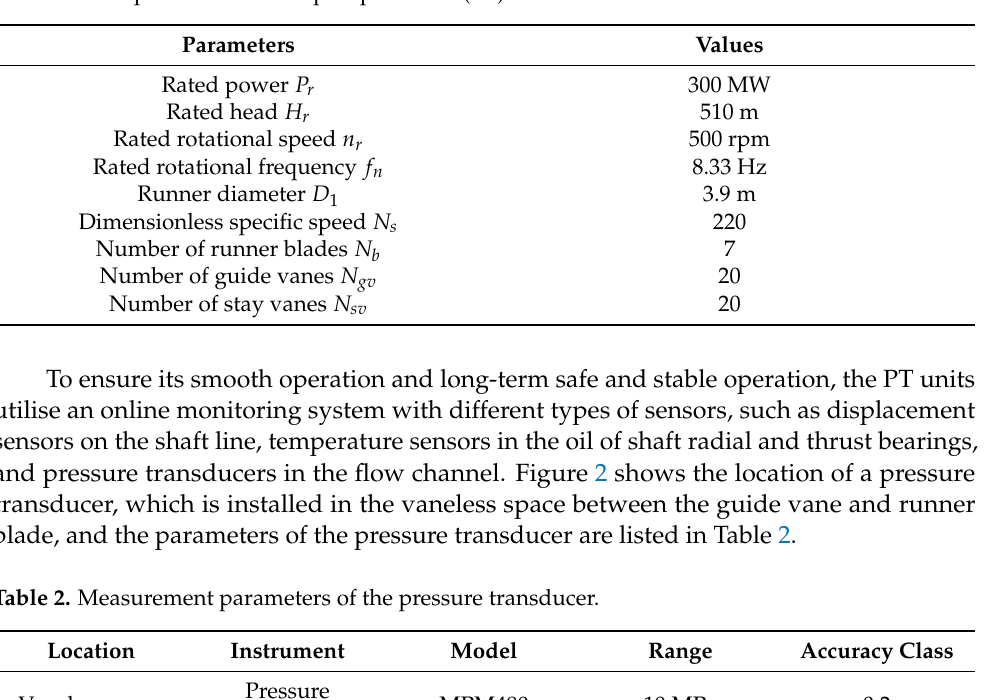
Figure 1. Three-dimensional model of the investigated pump–turbine (PT) unit. Table 1. Basic parameters of the pump–turbine (PT) unit.